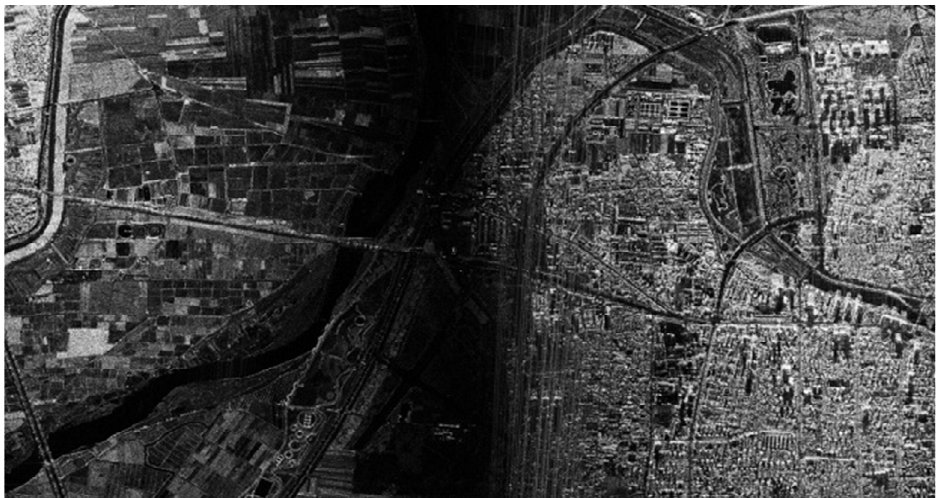
Figure 17. SAR image after DCC with relatively precise IPSR.